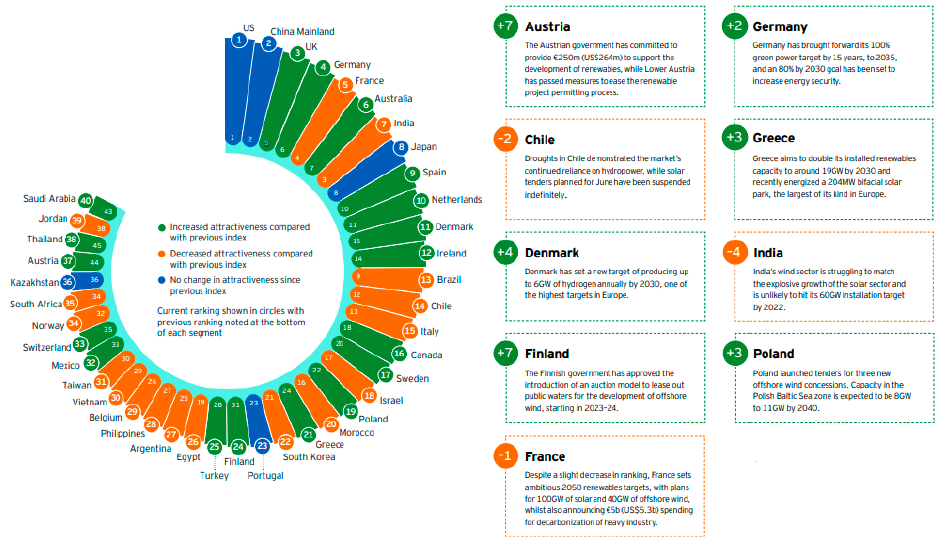
Figure 3. Renewable Energy Country Attractive Index (RECAI), Ernst and Young, 2022 [55].